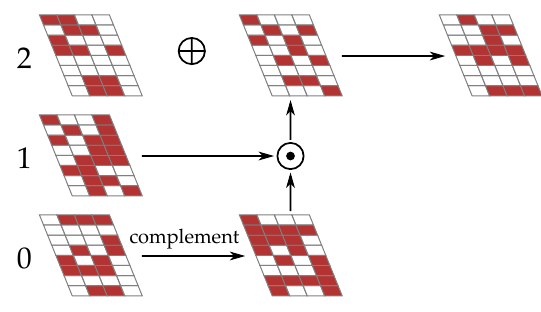
Figure 3: Effect of χ on one plane.